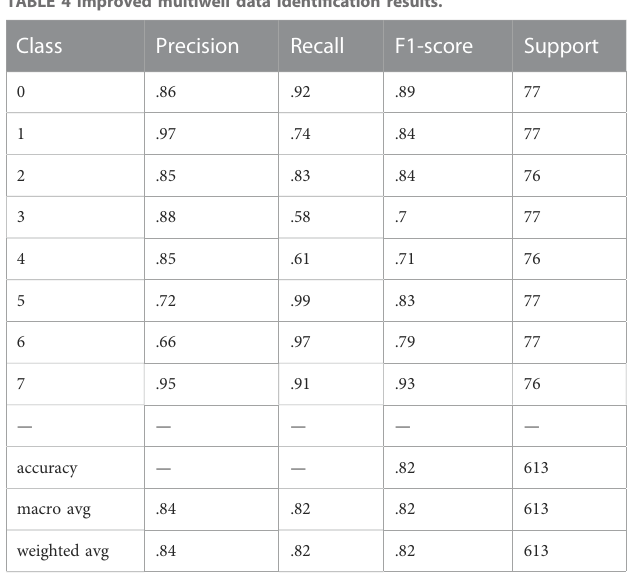
TABLE 4 Improved multiwell data identi fi cation